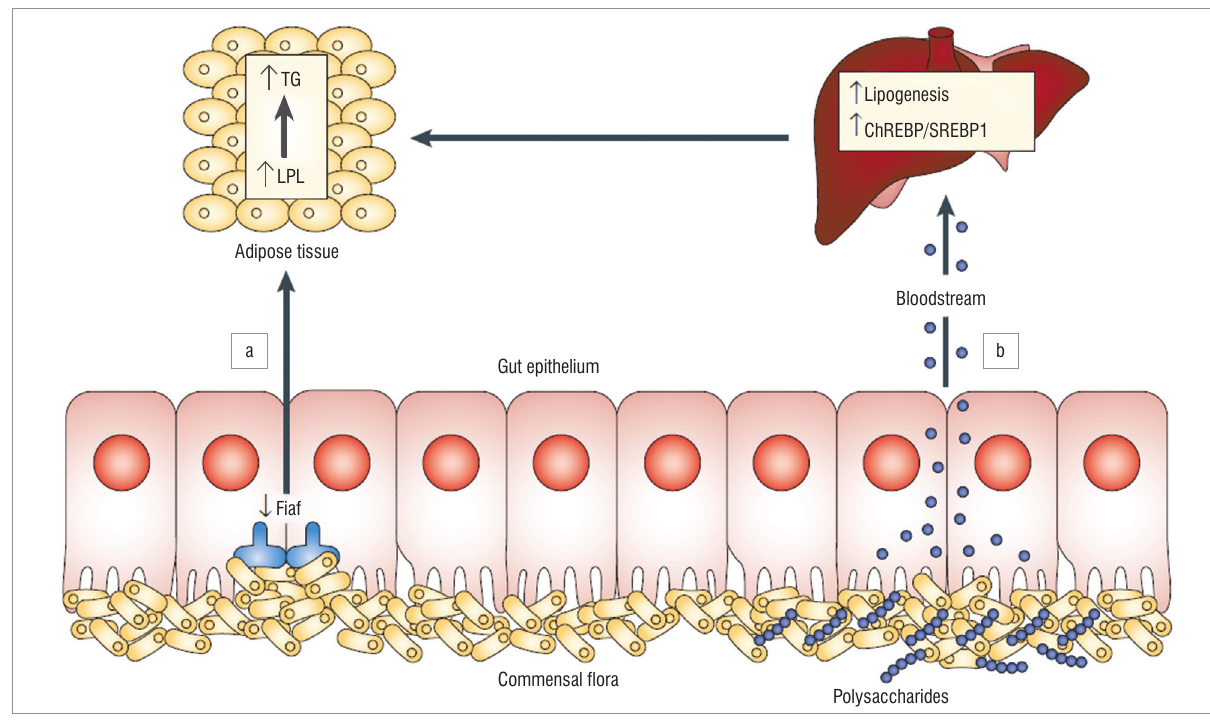
Figure 2: Schematic of how the gut microbiota affects fat storage in the host. The gut microbiota increases lipoprotein lipase (LPL) activity in adipocytes to promote storage of calories harvested from the diet into fat through two mechanisms. In the first mechanism, (a) the gut microbiota selectively suppresses fasting-induced adipocyte factor (FIAF, also known as ANGPTL4), a member of the angiopoietin-like family of proteins, leading to the up-regulation of LPL. In the second mechanism, (b) the gut microbiota metabolises the non-digestible polysaccharides and induces de novo hepatic lipogenesis via the absorption of resulting